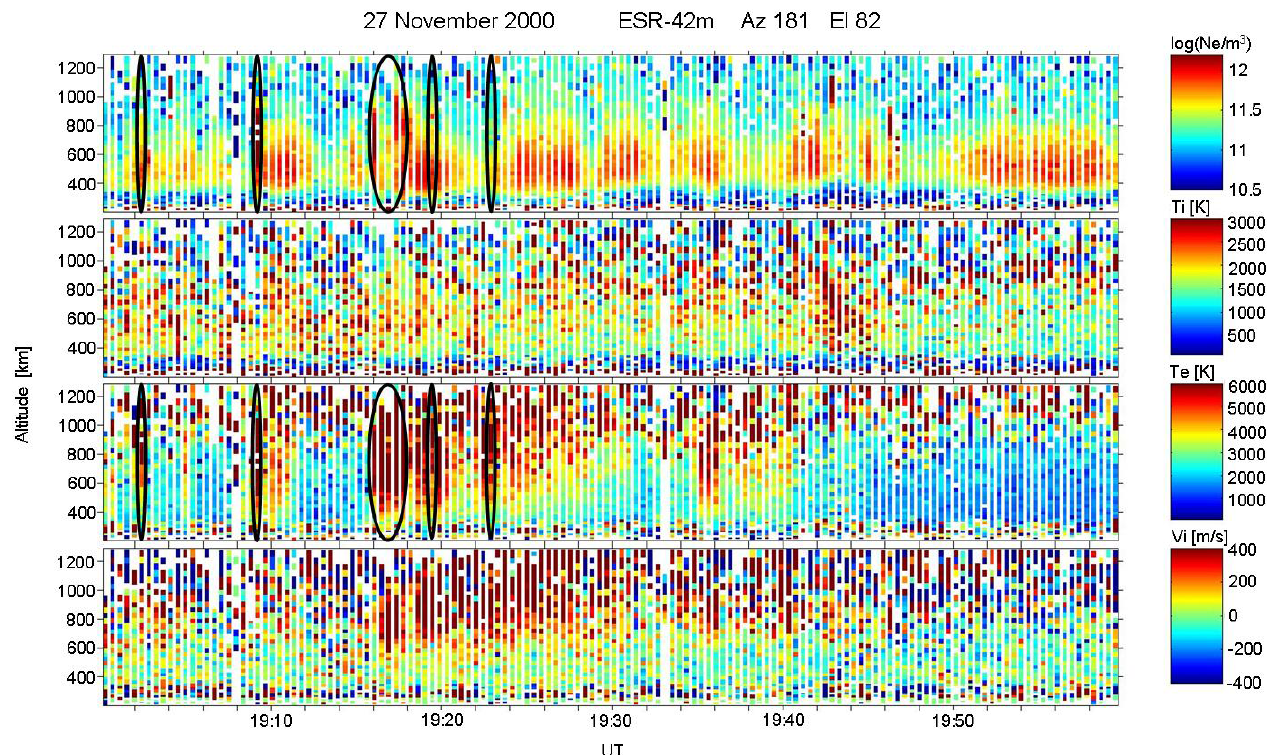
Fig. 3. A standard analysis of the ESR data where the panels show from the top to the bottom: the electron density, the ion temperature, the electron temperature and the ion drift velocity, respectively. The time of the NEIAL events is encapsulated by black